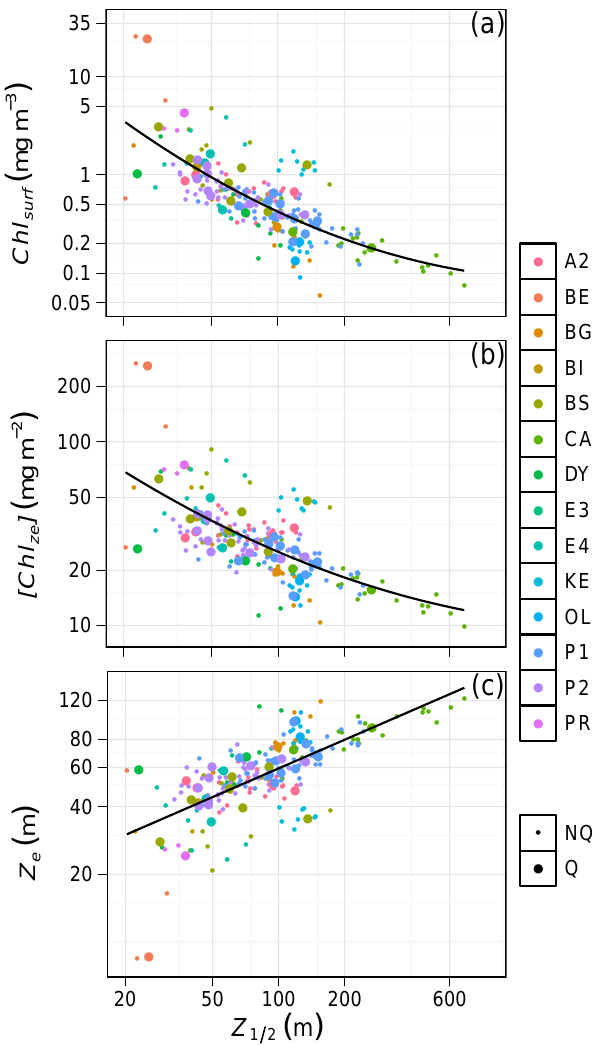
Fig. 8. Impact of quenching on the relationships presented in Fig. 5 (sigmoid profiles). The quenched status of the fluorescence profile is indicated by the size of the symbol. Large circle: quenched pro- file. Small circle: non-quenched